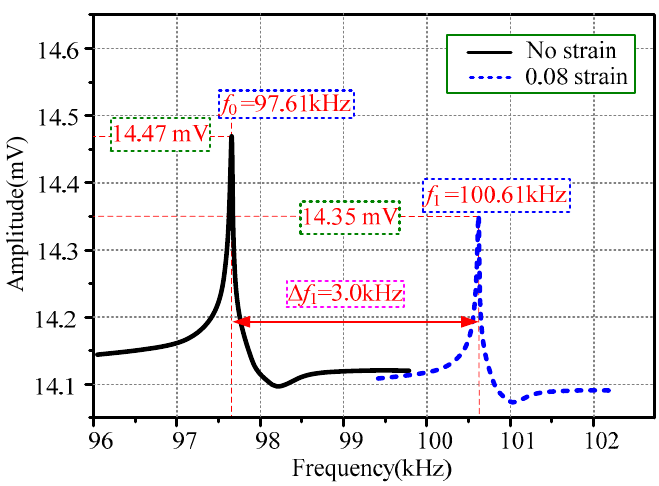
Figure 6. Frequency performance of the HSMS under a specific strain.